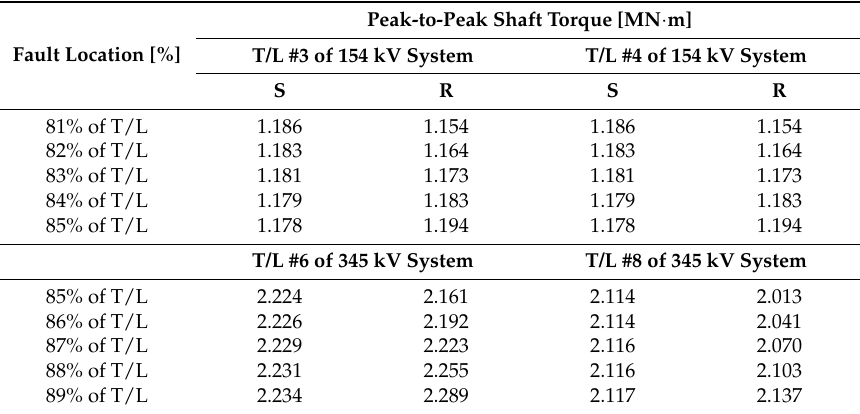
Table 4. Results of additional simulations according to the leader